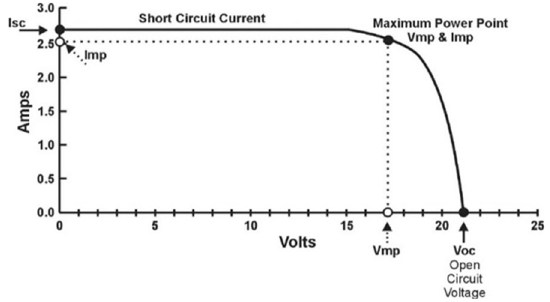
Fig. 2 General I-V curve of PV cell